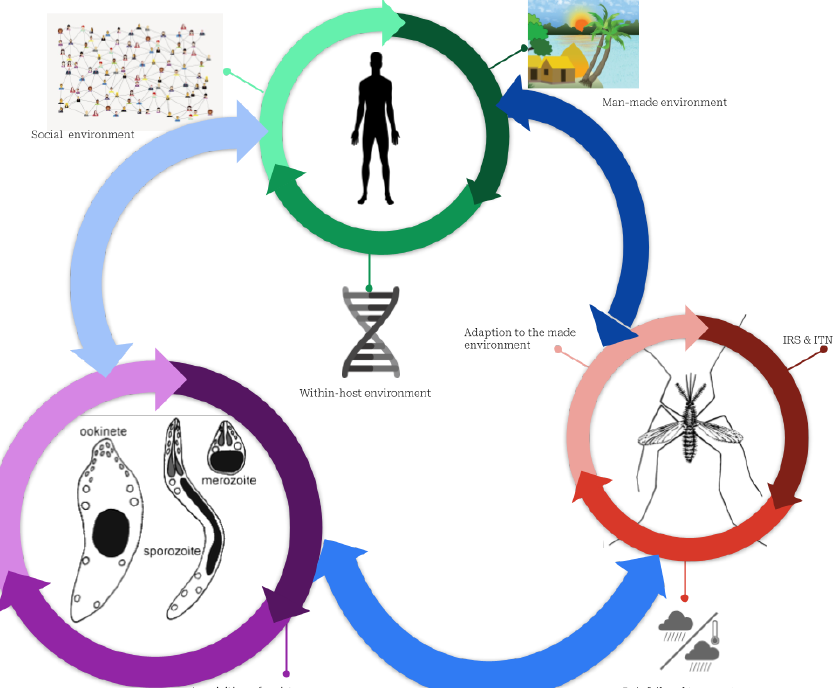
Figure 3. Complex interactions between humans, mosquitos, and parasites explaining the persis- tence of malaria. Plasmodium parasites, mosquitoes, and humans constitute three subsystems that interact with one another. The green cycle represents the human sub-system (SS). In addition to the micro-environment, which includes housing conditions, network connectivity, socioeconomic conditions, and the environment within the host (i.e., the individual’s genetic makeup), this SS is characterized by the social environment (social interaction, culture, and behavior regarding malaria risk-taking). The red indicates the SS of mosquitoes defined by the growth conditions favored by humans using or not either ITNs or IRS, and their adaptation to their living environment, including the harsh environmental conditions of cities, such as dirty water and weather conditions. In purple, Plasmodium parasite SS is characterized by interactions with the environment inside the host that may drive resistance to malaria drugs.